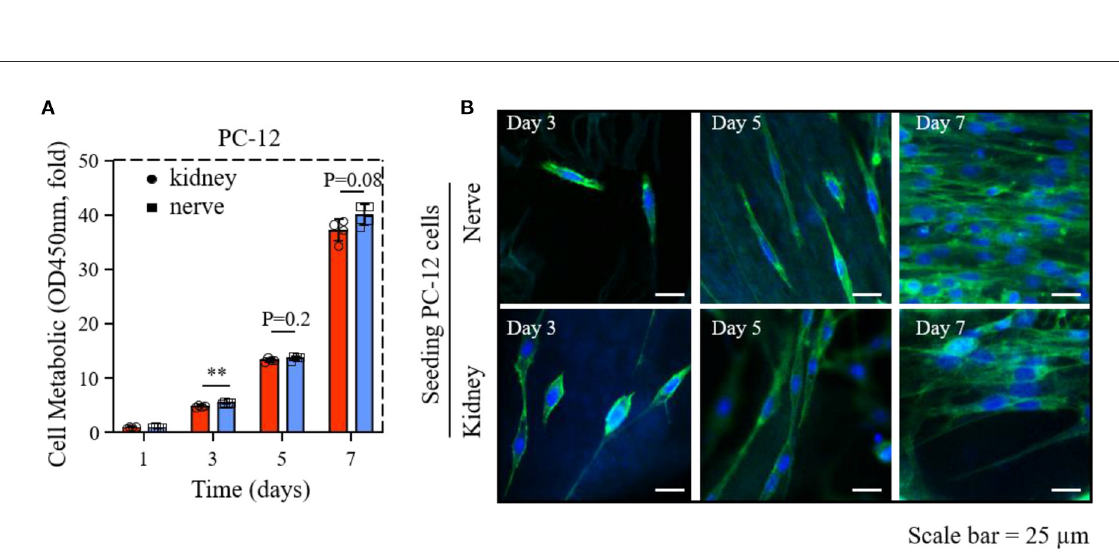
at day 3 showed a slightly higher proliferation rate than on dK ( P <